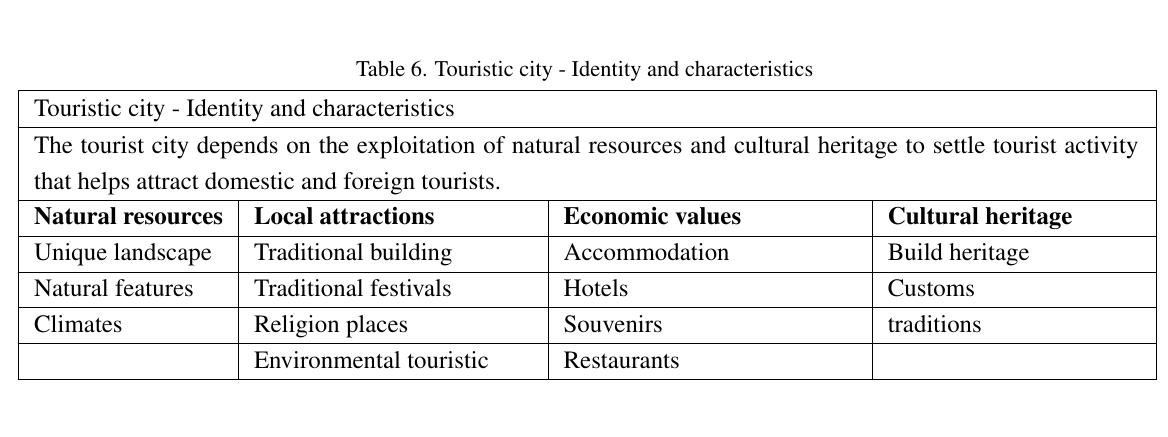
Table 7. Mixed city — Identity and